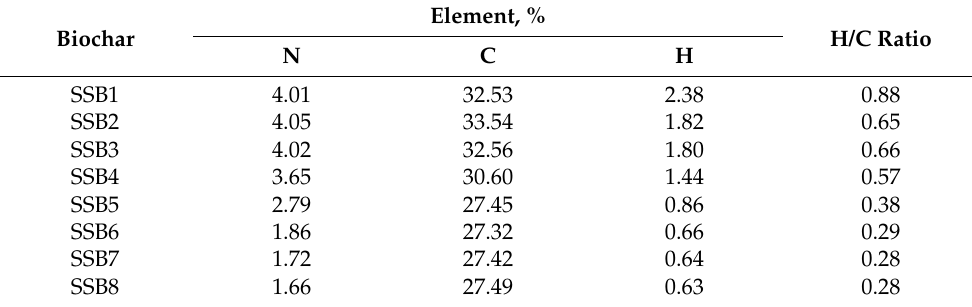
Table 6. The influence of time and temperature of the pyrolysis process on the CHN elemental analysis results.